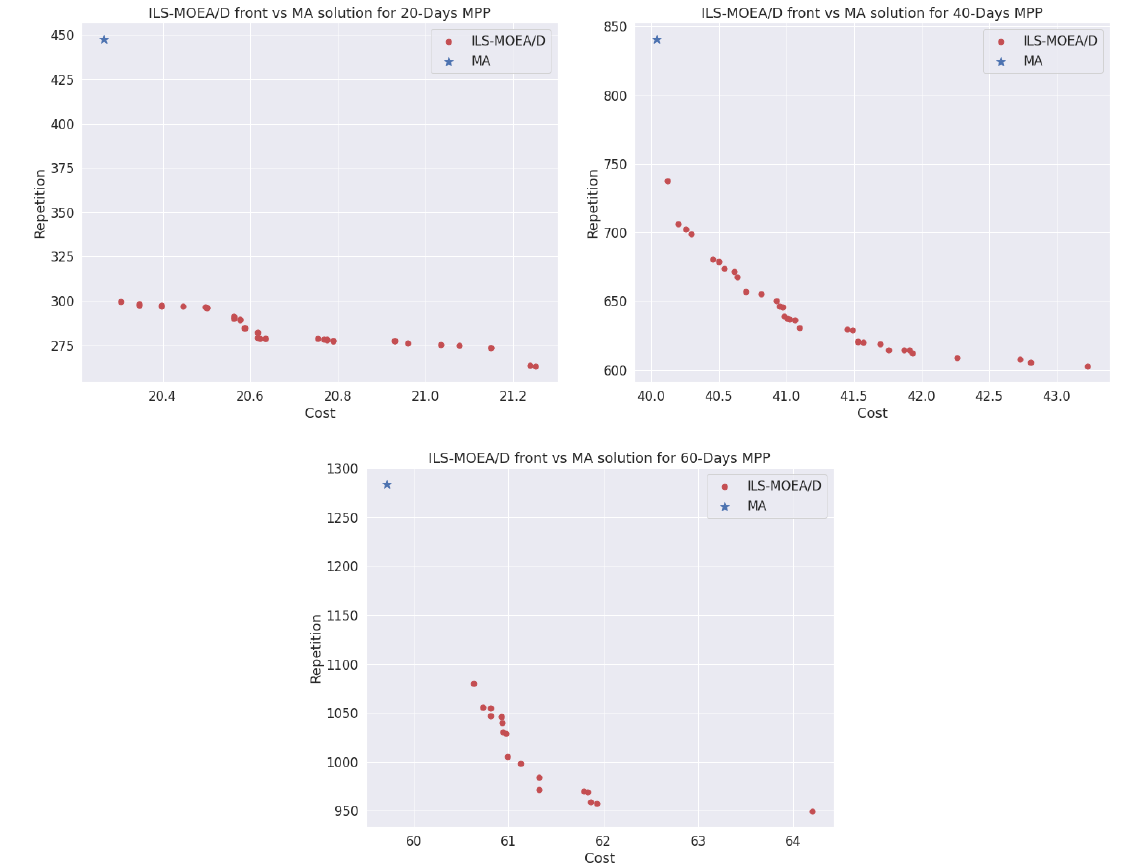
Figure 2. Comparison of the Pareto Fronts achieved by ILS-MOEA/D versus a two-dimensional representation of the best solution found by MA, i.e., the one with the lowest cost and lowest level of repetition, considering menu plans for n = 20 ( upper-left ), n = 40 ( upper-right ) and n = 60 ( bottom ) days. The reader should recall that the level of repetition of the solutions attained by MA had to be computed separately. To this end, the same source code implemented in the case of the multi-objective constrained formulation of the MPP was